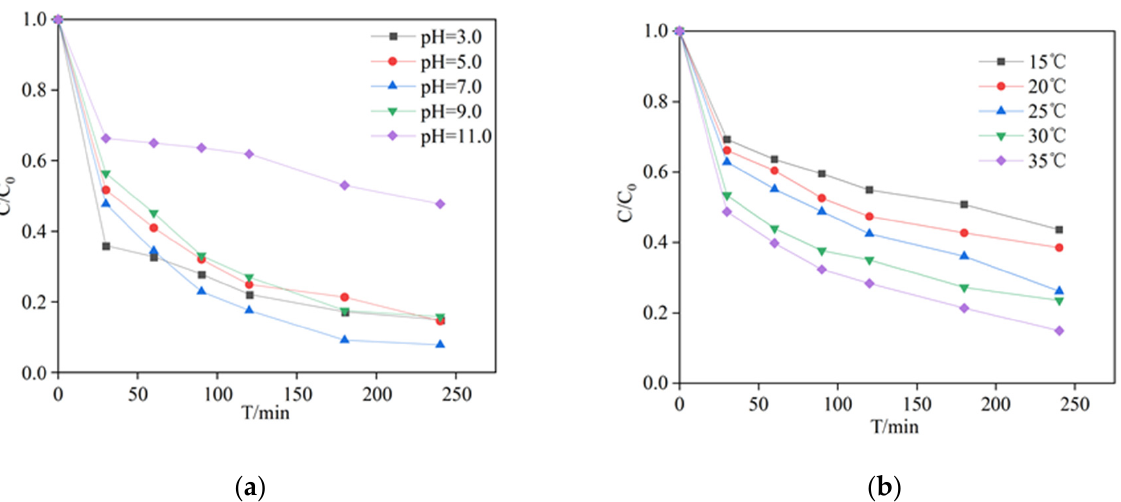
Figure 4. The effect of the following factors on PCA concentration ratio: ( a ) initial pH, experimental conditions: [PCA] = 20 mg/L, [PDS] = 2.4 mM, [MnFe 2 O 4 ] = 1.3 g/L and T = 25 °C. ( b ) Solution temperature, experimental conditions: [PCA] = 20 mg/L, [PDS] = 2.4mM, [MnFe 2 O 4 ] = 0.5 g/L and T = 15–35 °C.